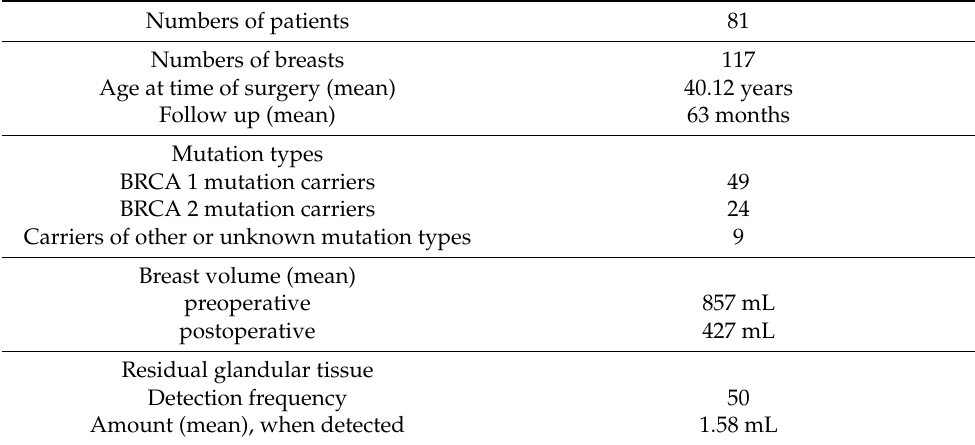
Table 1. Study cohort